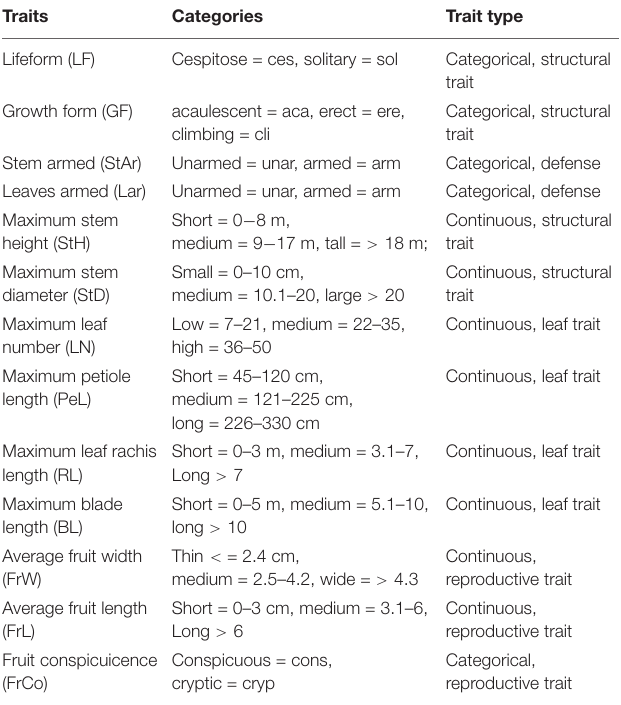
TABLE 1 | Functional traits of 116 palm species registered in western